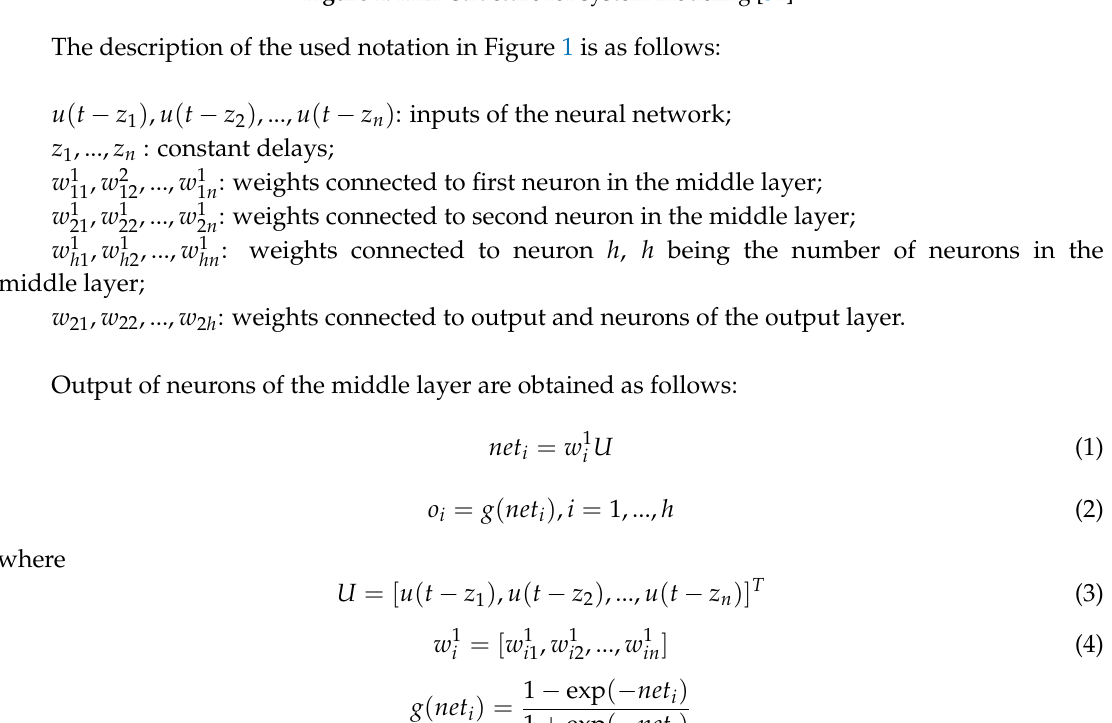
Figure 1. MLP structure for system modeling